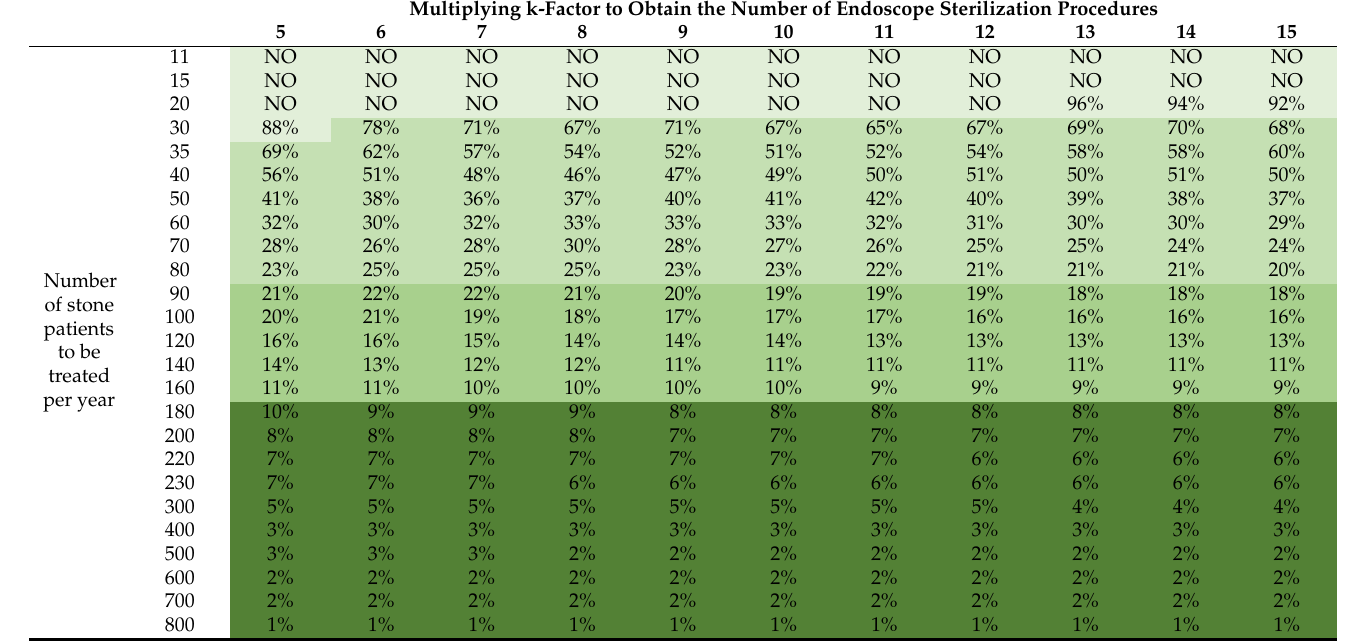
Table 2. Cut-off value for private hospitals in the case of the relevant hybrid